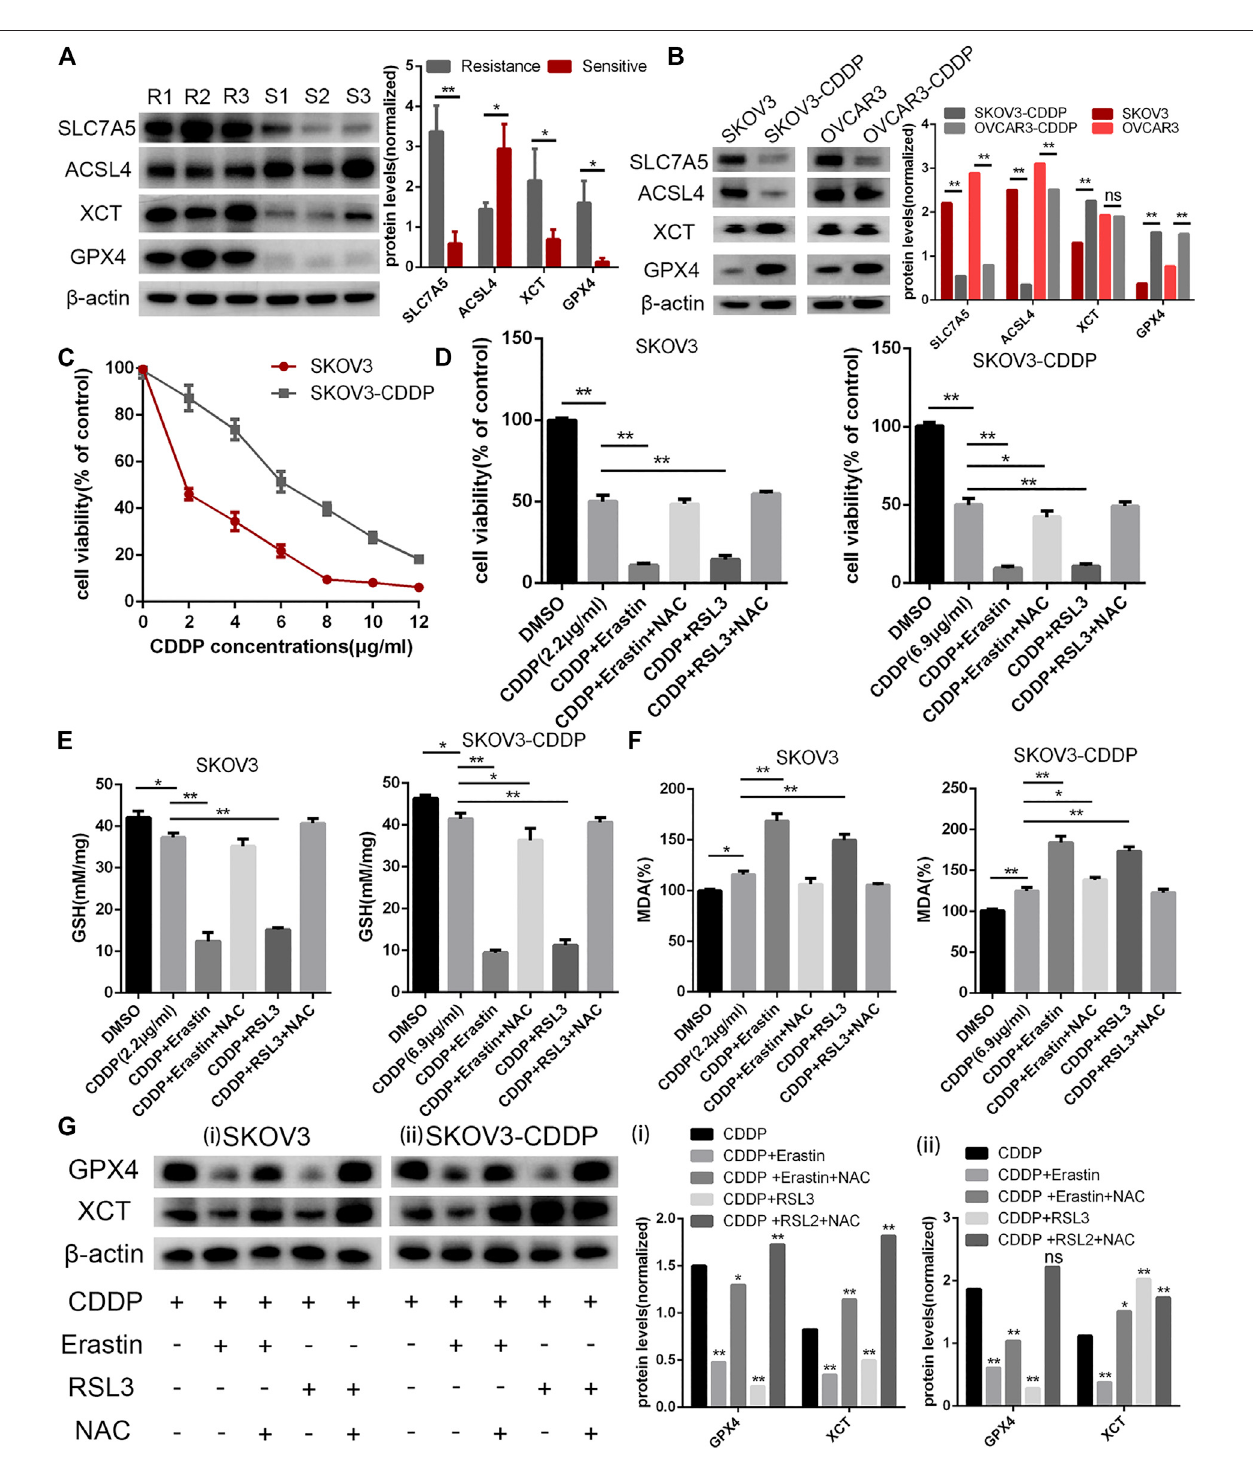
FIGURE 4 | Analyses of survival-related FRGs in OC. (A) Ferroptosis pivot genes, namely, SLC7A5, ACSL4, XCT, GPX4, and β -actin protein expression in platinum-resistanttissues(R1-R3)andplatinum-sensitivetissues(S1-S3). (B) SLC7A5,ACSL4,XCT,GPX4,and β -actinproteinexpressioninovariancelllines(OVCAR3 and SKOV3) and platinum-resistant OC cell lines (OVCAR3-CDDP and SKOV3-CDDP). (C) Cell viability assays under cisplatin treatment; SKOV3/CDDP showed higher cisplatin tolerance,representing the resistance phenotype. Cells were treated with cisplatin (2.2 μ g/ml forSKOV3 and 6.9 μ g/ml forSKOV3-CDDP) in theabsence or presence of erastin (10 μ M), RSL3 (0.1 μ M), and NAC (1 mM) for 24 h and cell viability. (D) Glutathione (GSH) (E) and lipid peroxidation (MDA) assays (F) were performed. (G) XCT, GPX4, and β -actin protein expression in SKOV3 (i) and SKOV3-CDDP (ii) under the abovementioned treatment. Error bars represent the standard deviation (s.d.) of triplicate measurements. * p < 0.05 and ** p < 0.01.